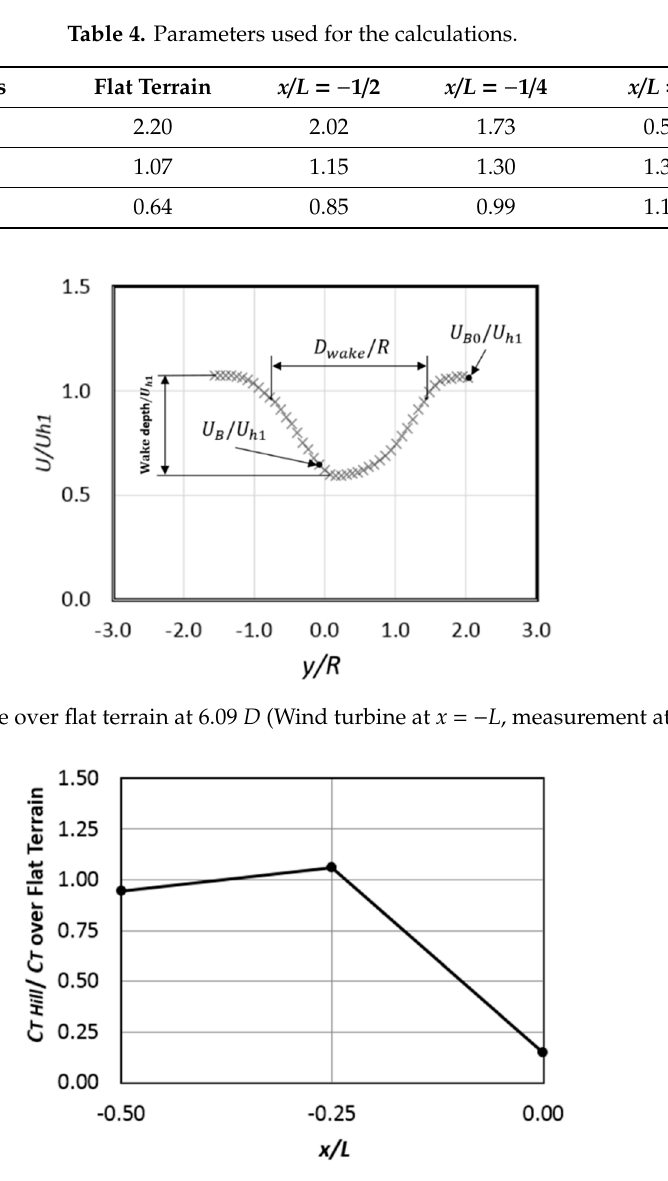
Figure 14. 𝐶 (cid:3021) (cid:3009)(cid:3036)(cid:3039)(cid:3039) / 𝐶 (cid:3021) over flat terrain at locations 3 to 5. Figure 14. C T Hill / C T over flat terrain at locations 3 to